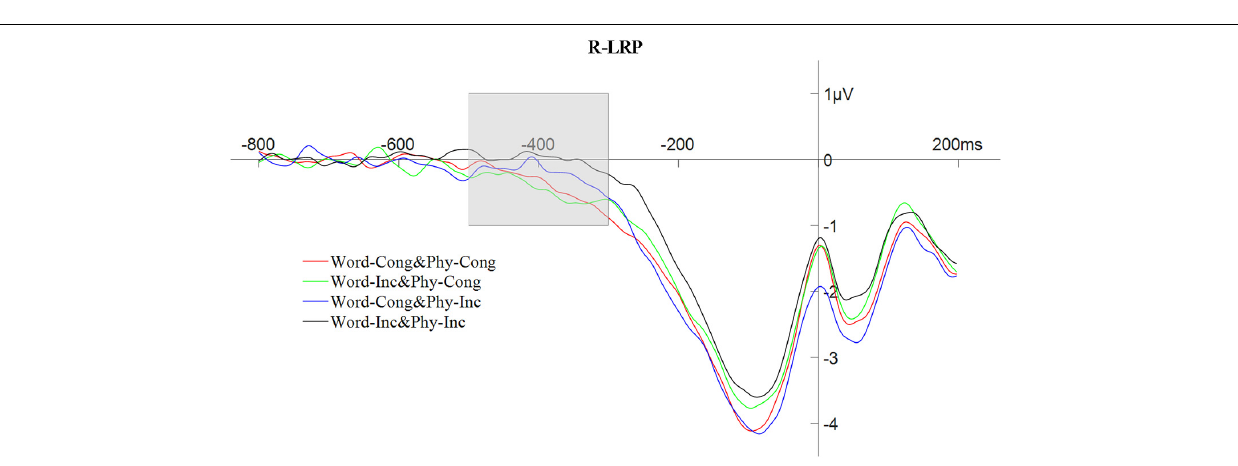
words were displayed incongruently with the locations they refer to – which was indeed observed in the present